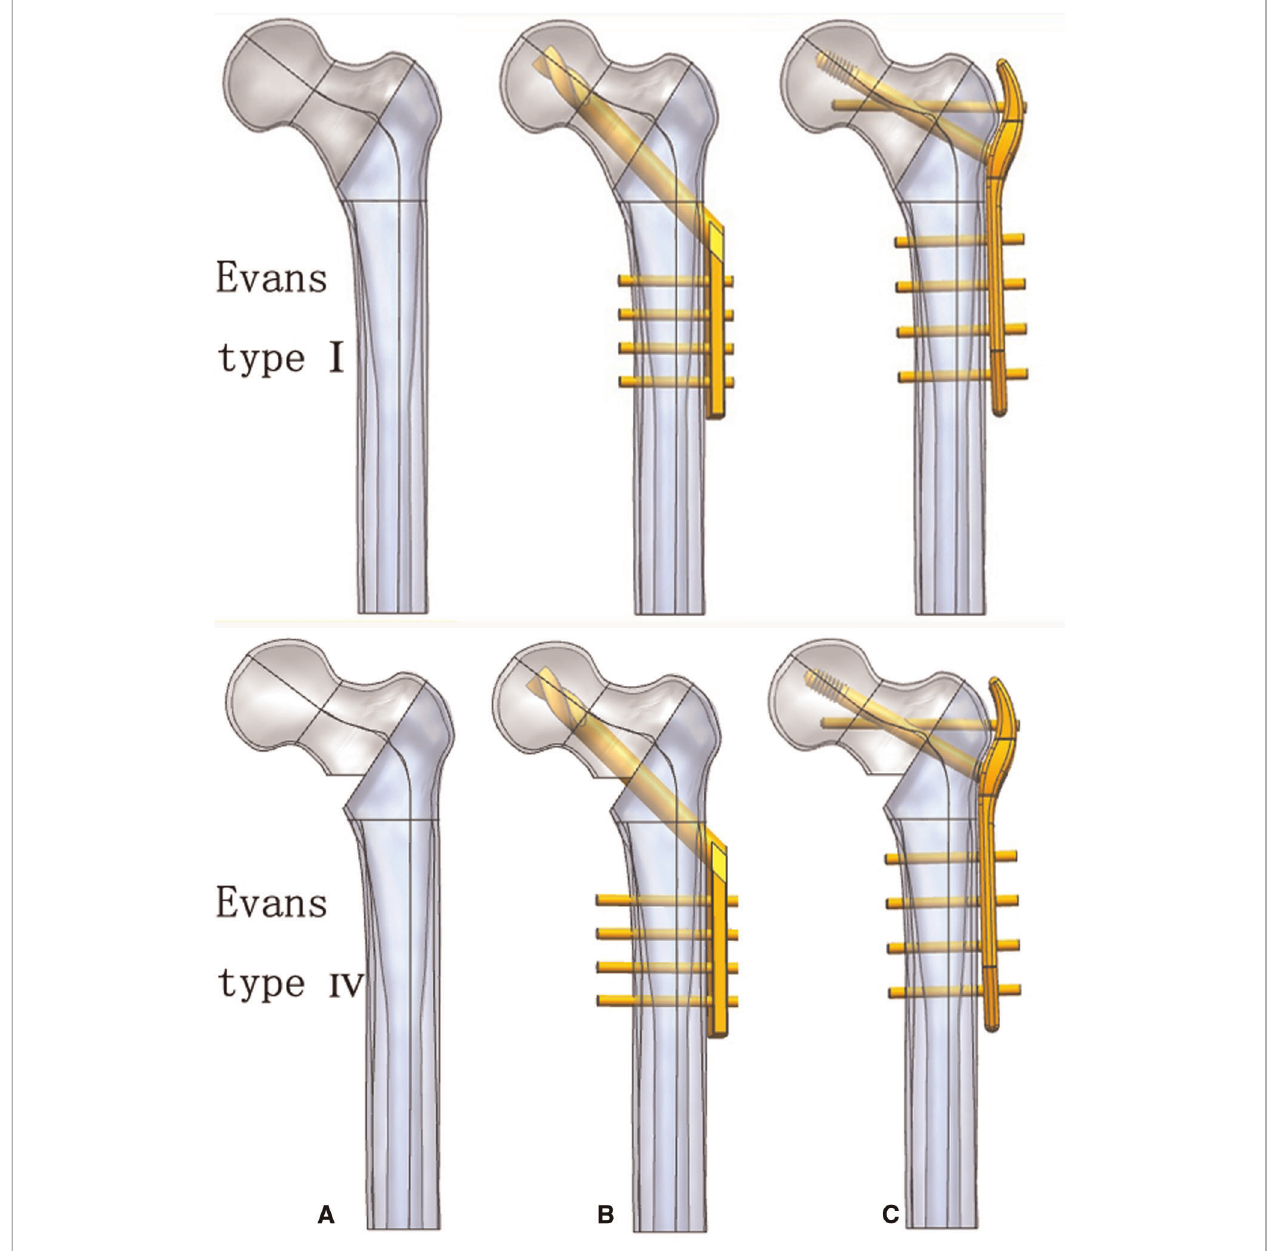
FIGURE 2 | Geometric modeling of stable and unstable intertrochanteric fracture models and three implant fi xation models; ( A ) the Evans type I and IV intertrochanteric fractures; ( B ) DHS fi xation model; and ( C ) TSFP fi xation